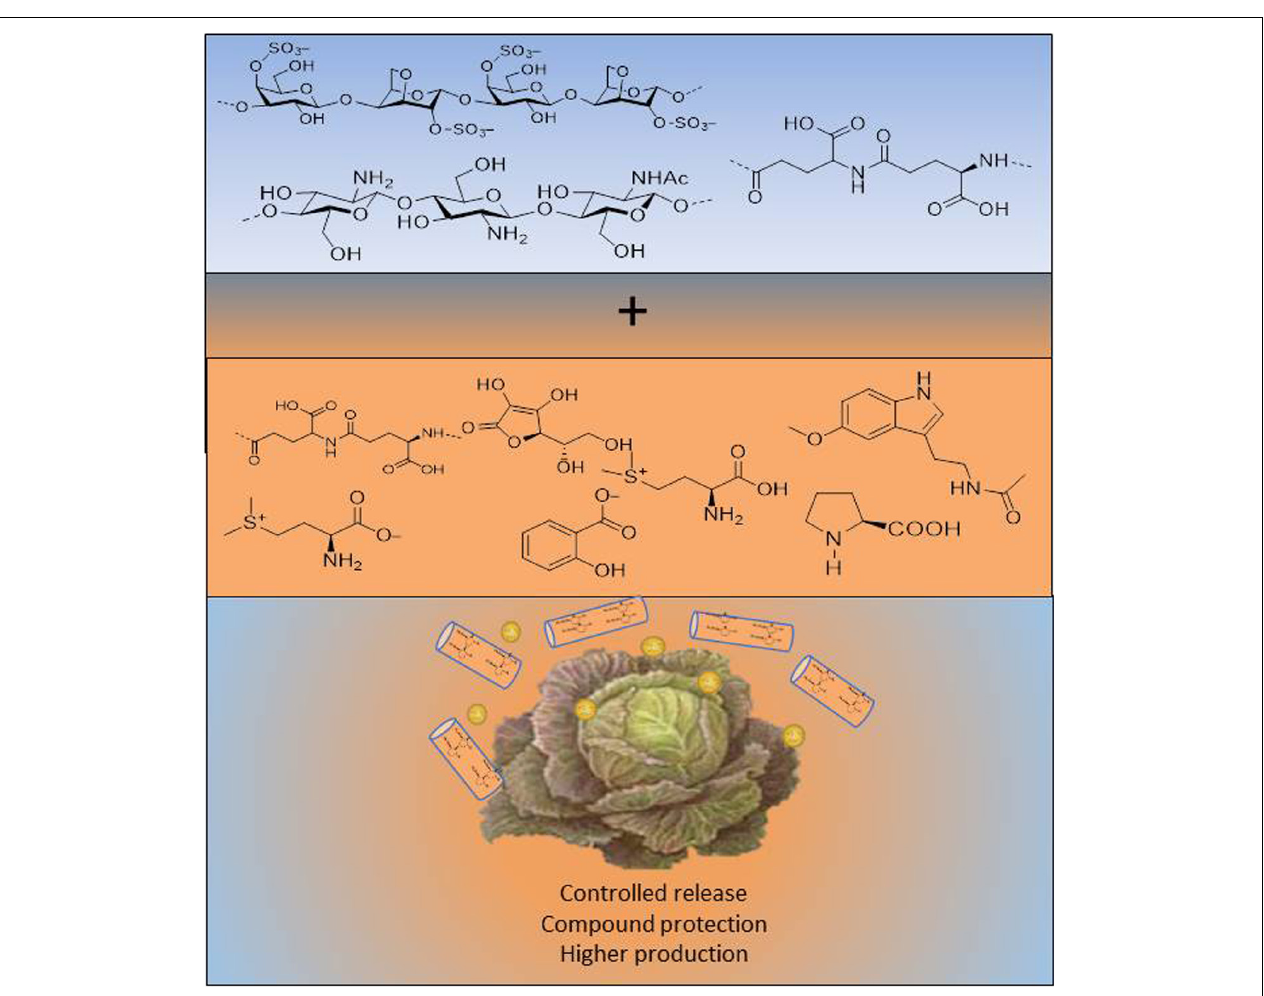
FIGURE 5 | Benefits of nanoencapsulation of